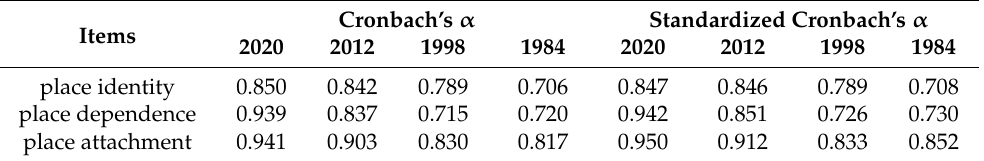
Table 3. The reliability of each dimension of the sense of place.